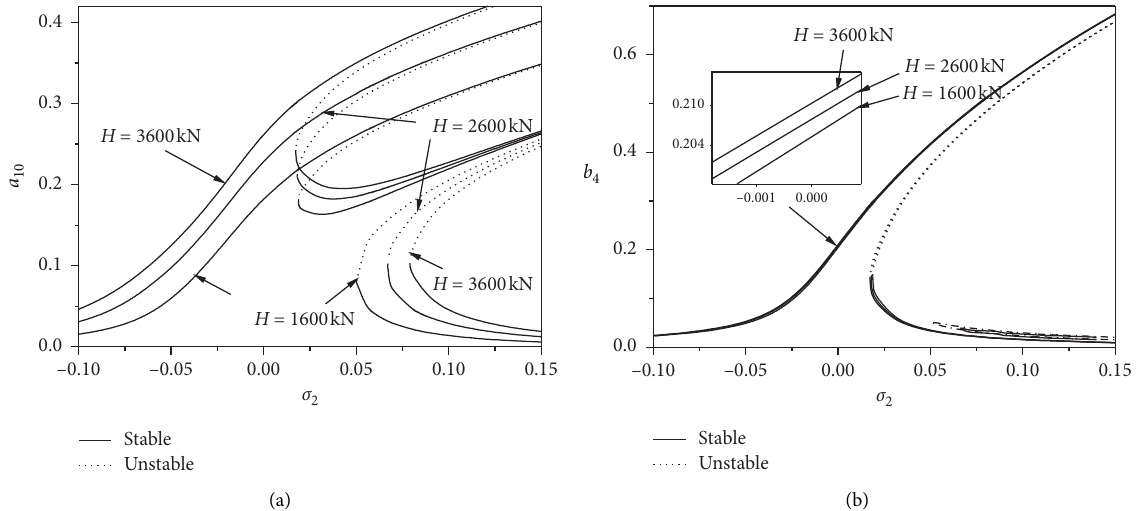
Figure 13: Effect of initial tension ( H ) on the frequency-response curves of the (a) cable and (b) shallow arch with Ω